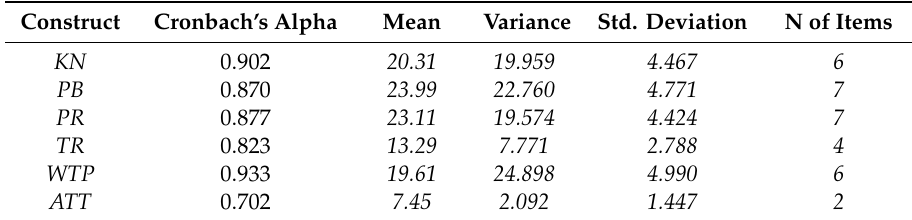
Table 3. Model Construct